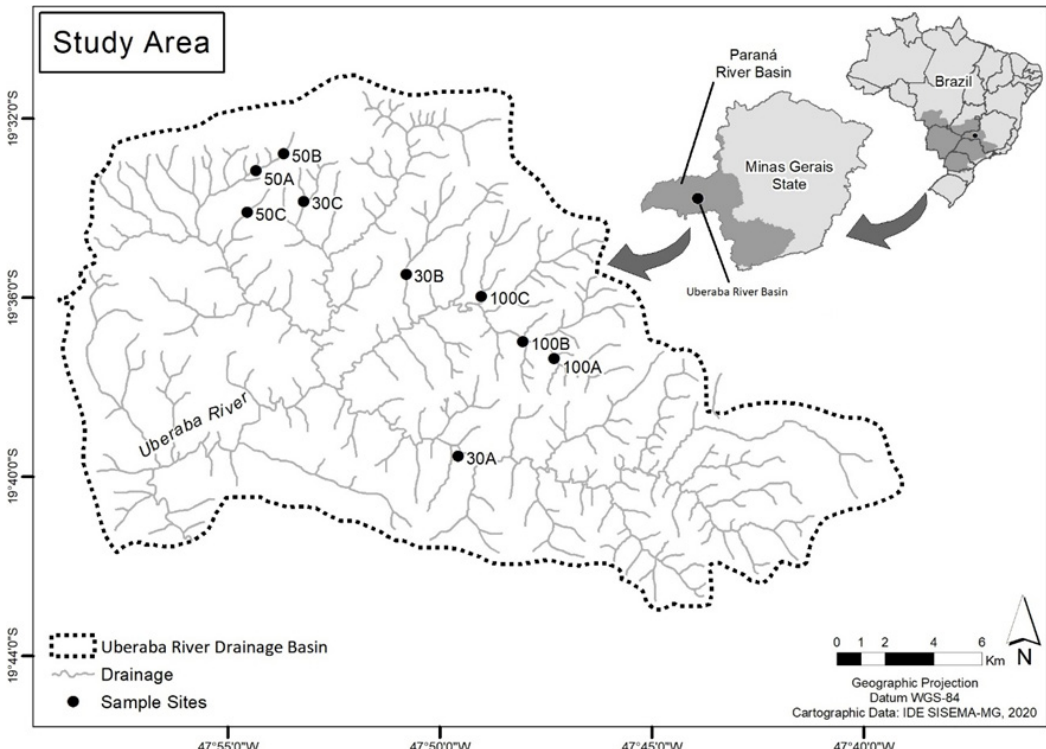
Figure 1. Location of the sampling sites in the Uberaba River drainage basin, a tributary of the Rio Grande